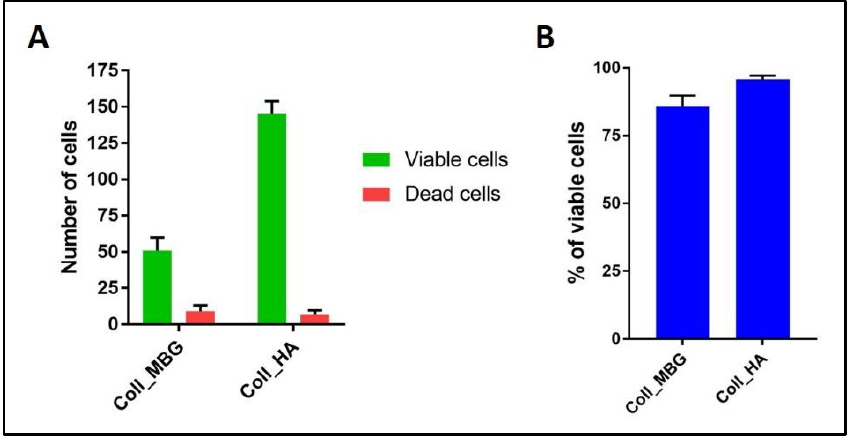
Figure 18. Diagram of the results at 7 days using the live-dead assay on osteoblasts seeded on the collagen-based scaffolds with nano-hydroxyapatite (Coll_HA) and collagen-based scaffolds containing mesoporous bioactive glasses (Coll_MBG). In ( A ) the number of viable and dead cells, and in ( B ) the percentage of viable cells are represented.